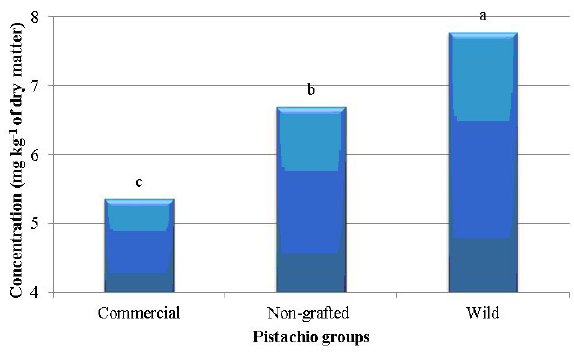
Fig. 1. The aluminium concentration of eleven Iranian pistachio samples. (Each column with different letters is significantly dif- ferent (P < 0.05)